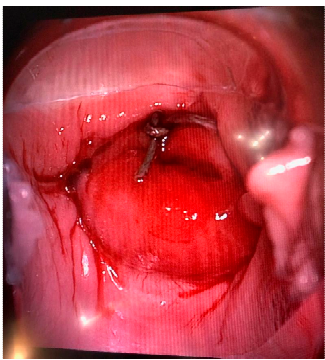
Figure 3. Colposcopy performed 2 months after radical trachelectomy.